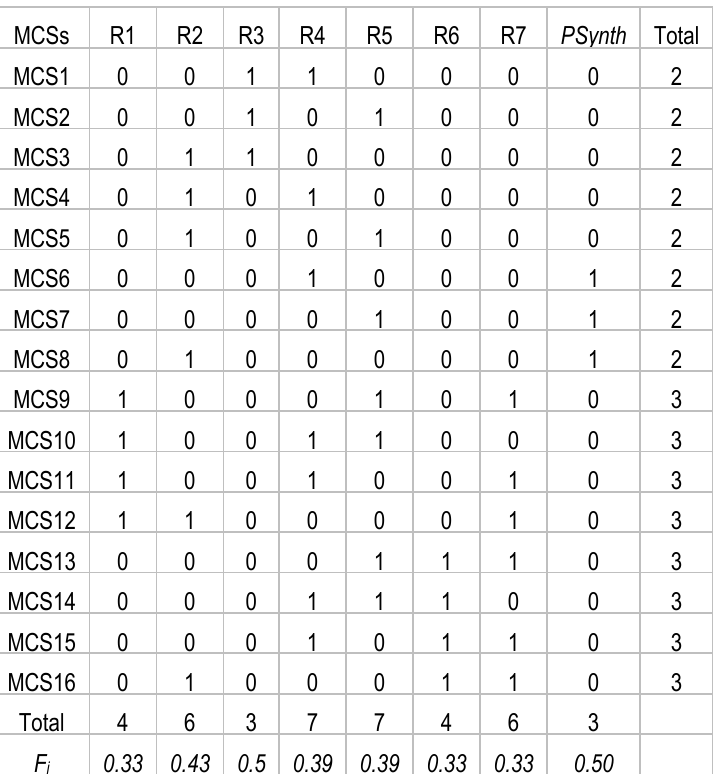
Table 5. MCSs for NetEx, where all the EMs form the objective function. A “1” in the row of a MCS indicates inclusion of that reaction in the MCS, e.g, MCS1 consists of reactions R3 and R4, which means that simultaneous blocking of R3 and R4 would collapse NetEx